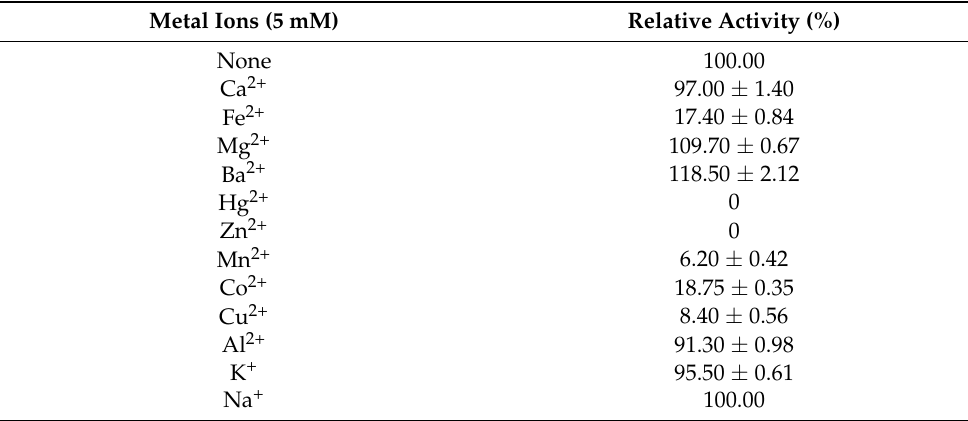
Table 2. Effects of various metal ions (5 mM) on BCA activity.